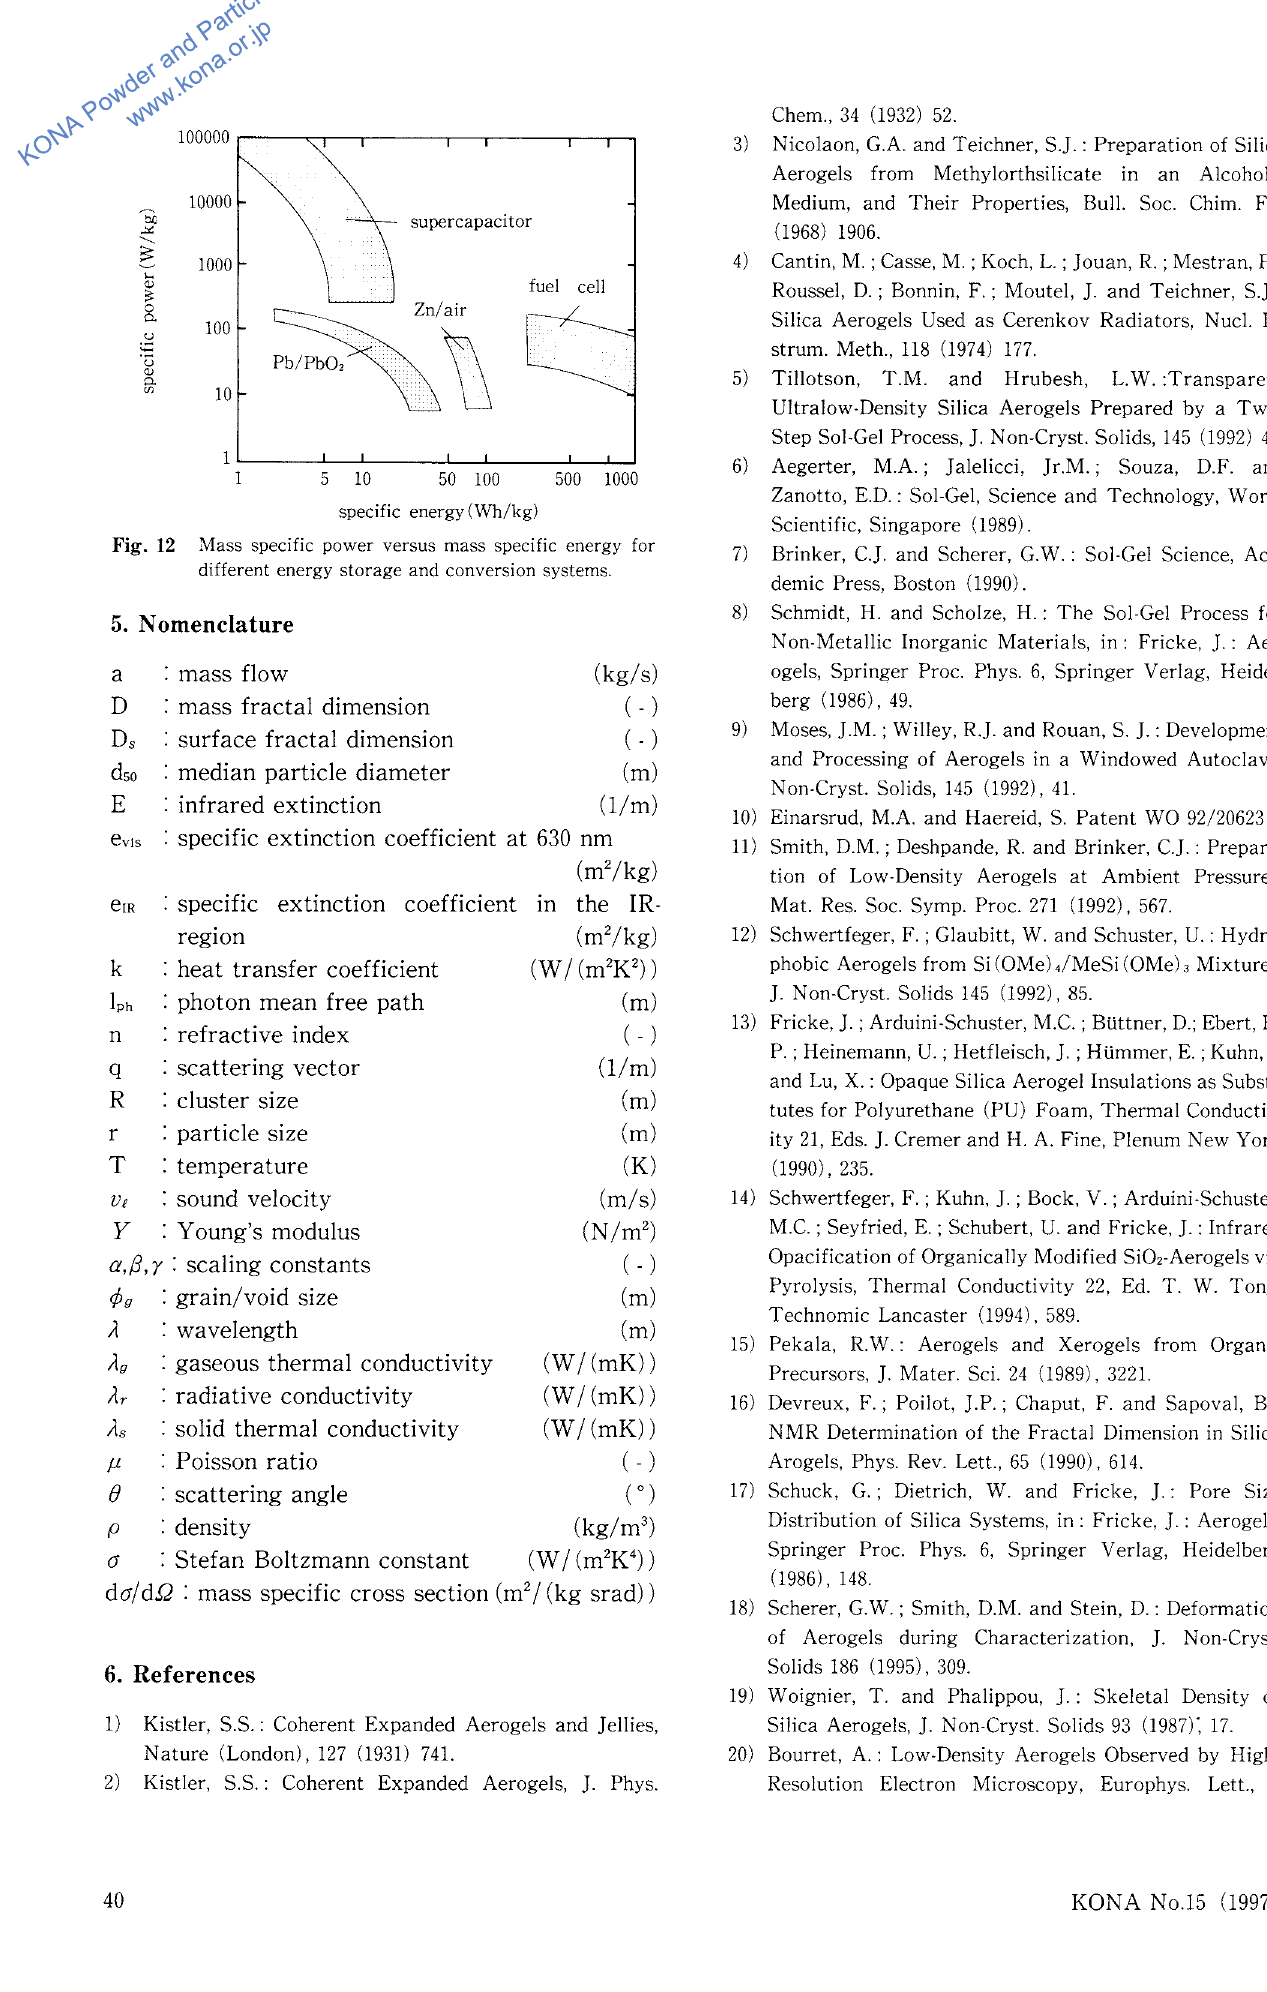
Fig. 12 Mass specific power versus mass specific energy for different energy storage and conversion